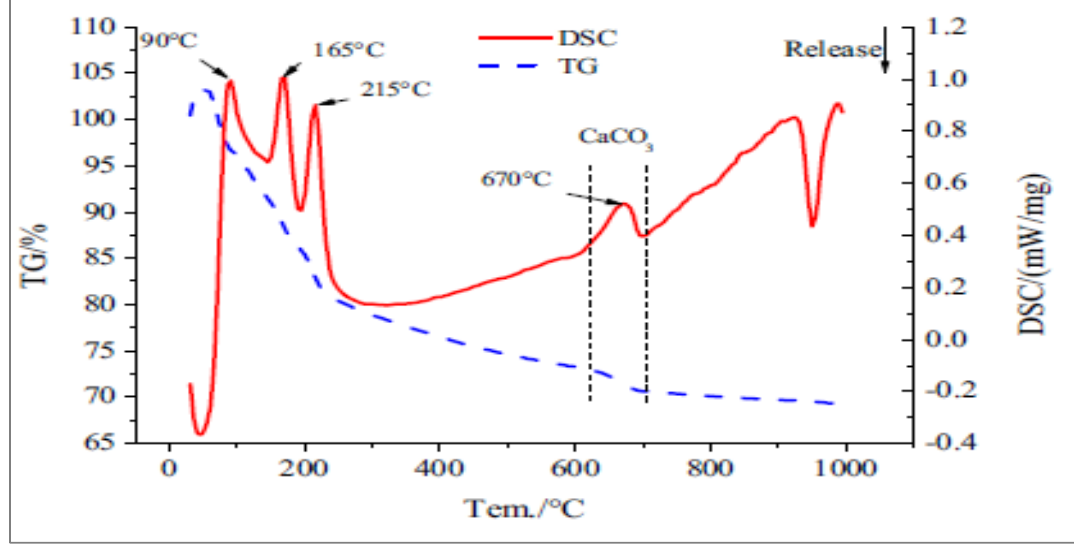
Figure 15. DTG of MTK: Reprinted with permission from [44].